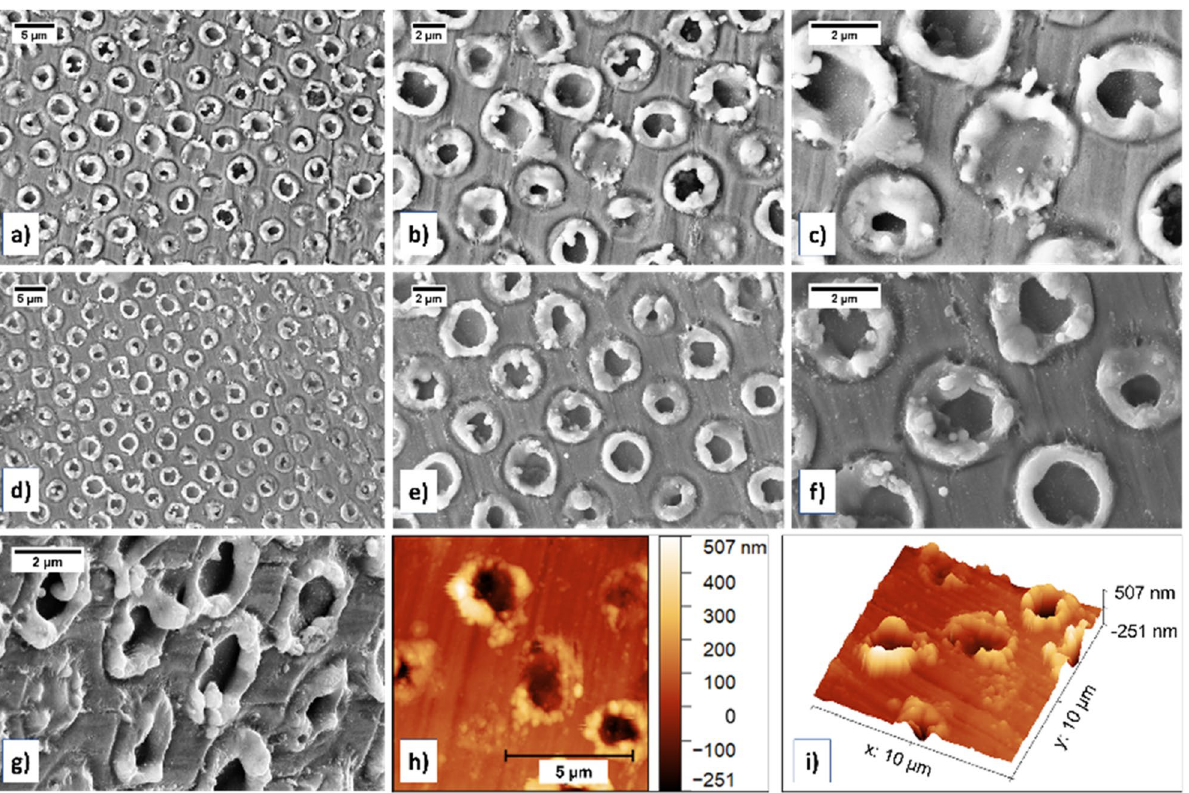
Figure 2. FESEM micrographs for DLIP on zinc in scCO 2 ( a – c ) and liquid CO 2 ( d – f ) at 100 bar pressure. Presence of round ordered structures donut/ring pattern was observed for both environments, without any significant difference. ( g ) Tilt-view FESEM micrograph revealed protruding slightly irregular surface on donut rings on the zinc target formed by DLIP in scCO 2 with a crevice in the centre. Atomic force microscopy (AFM) image showing topographical ( g ) 2D and ( h ) 3D images of donut ring pattern on zinc.